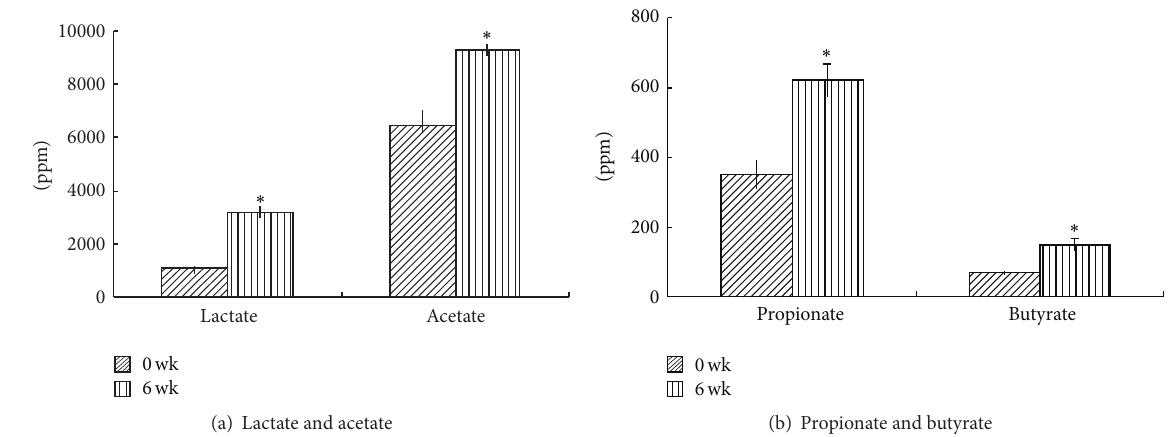
Figure 2: Effect of 3-prebiotic formula administration on contents of fecal organic acids. (a) Products of lactate and acetate and (b) propionate and butyrate. Data are expressed as the mean ± SD. ∗ Values significantly differ compared to that of week 0 of the administration period ( 𝑝 < 0.05